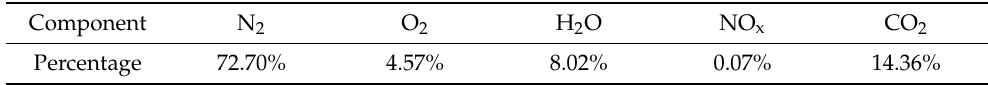
Table 2. Composition of inlet flue